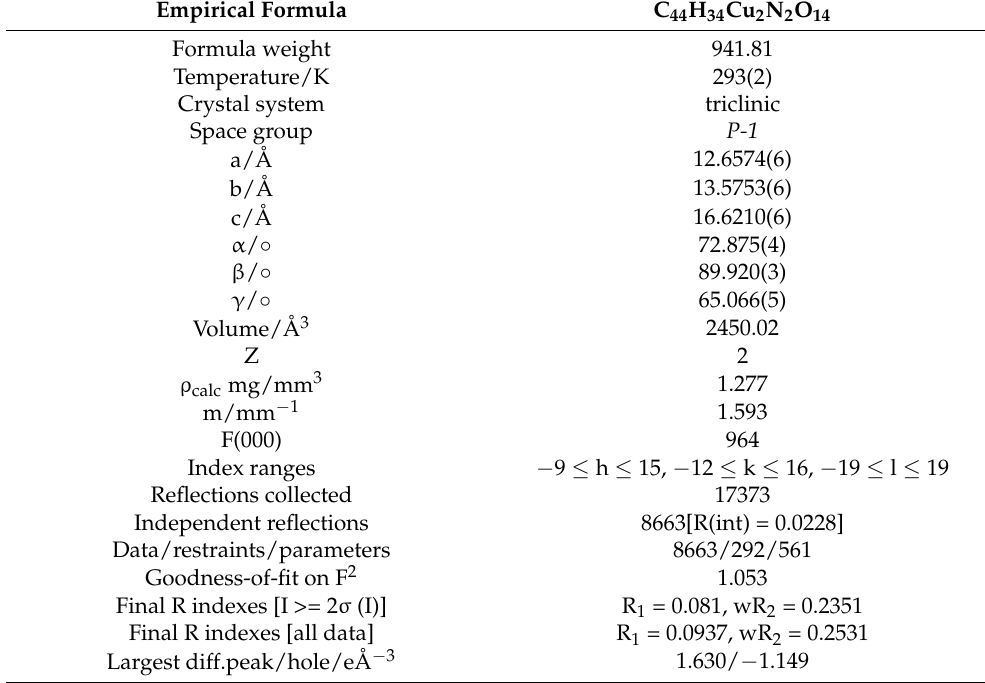
Table 1. Crystal data for LDU-1.